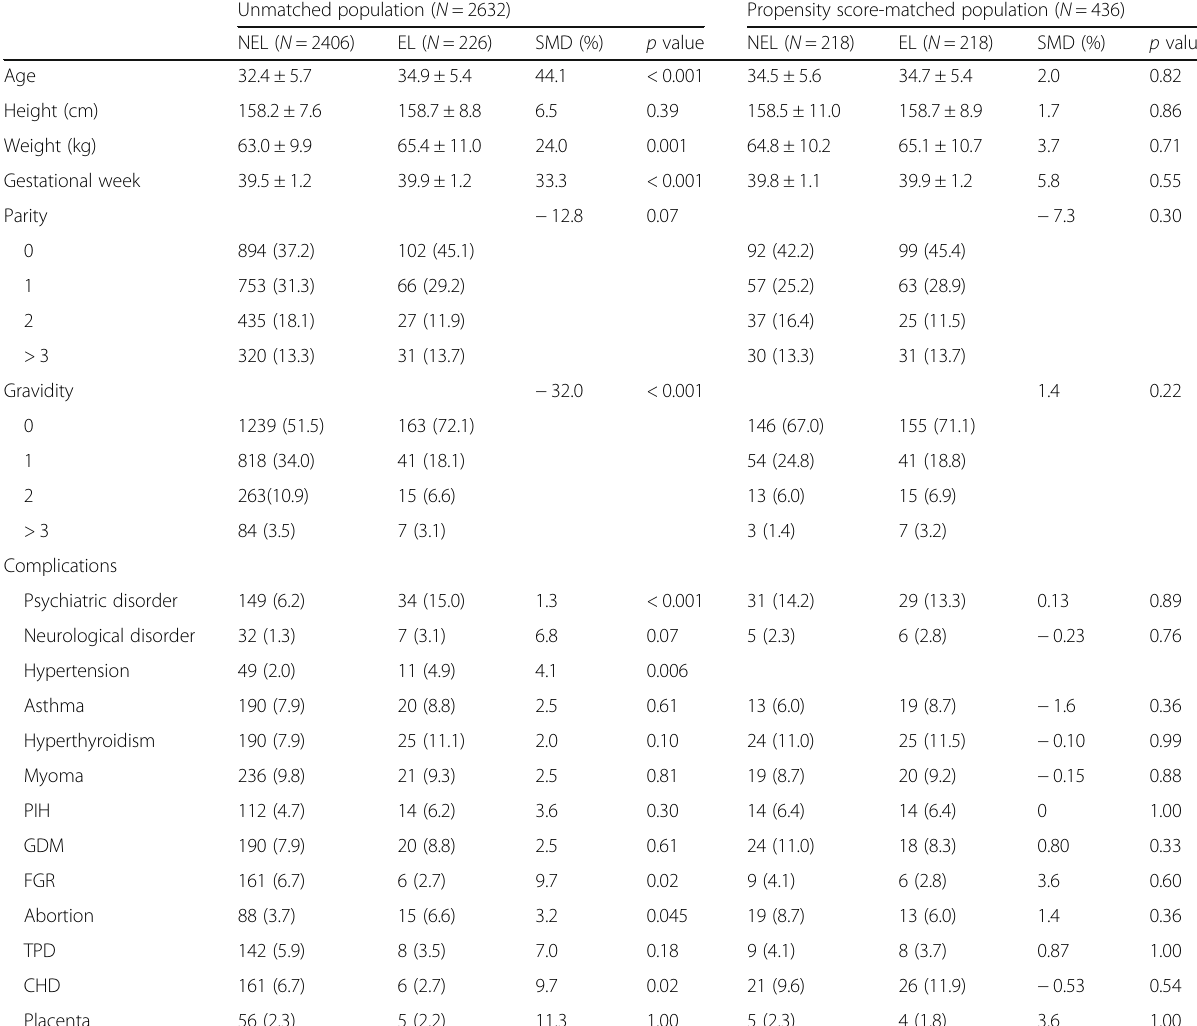
Table 1 Baseline characteristics of women between NEL and EL groups Unmatched population ( N =